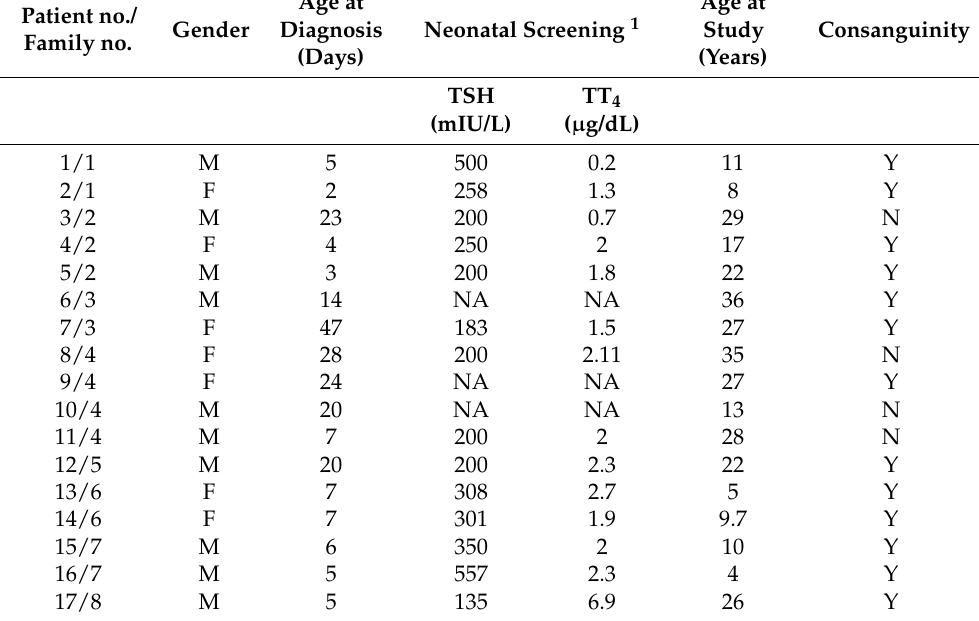
Table 1. Patient characteristics. Patient